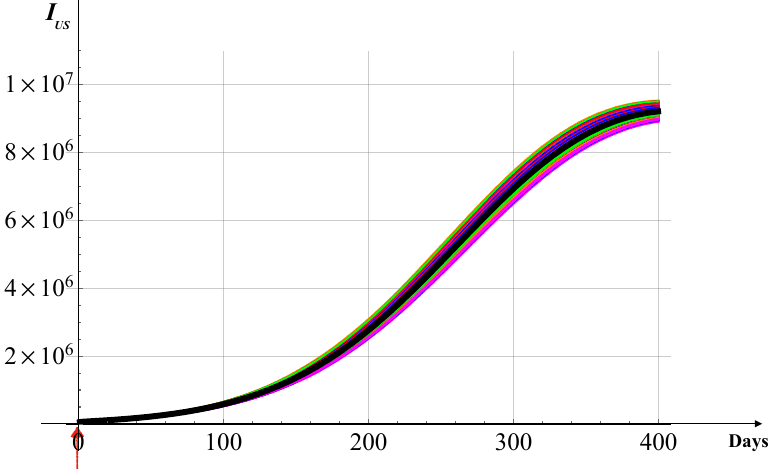
Figure 28. Set of paths (200 realisations) of the stochastic differential equation for the USA’s first wave. The values of the parameters are those reported in Figure 22. The intensity of the noise, has been set arbitrarily at the value ˜ η = 0.009, i.e., 45 times greater than the value estimated by Equation (65).